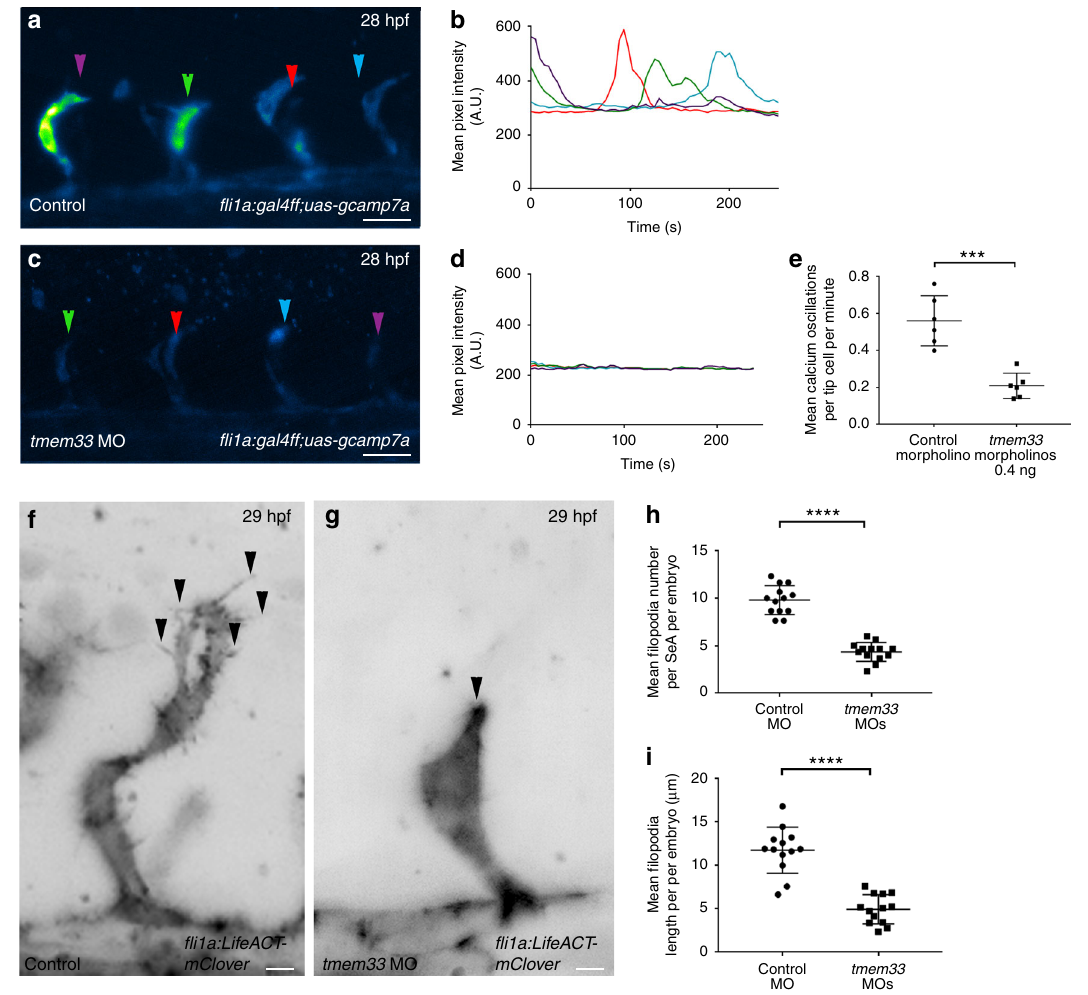
Fig. 2 tmem33 knockdown reduces Ca 2 + oscillations in tip cells and reduces EC fi lopodia. a – d tmem33 morphants injected with 0.4 ng morpholinos display reduced endothelial Ca 2 + oscillations. Intensity projections show Ca 2 + oscillations in both control and tmem33 morphants, highlighting intensity over duration of the time lapse. Change in fl uorescence over 300 s for four SeAs, trace colours correspond to equivalent arrowheads (scale bars 50 µ m). e tmem33 morphants display a signi fi cant reduction in Ca 2 + oscillations when compared with control morphants (unpaired t -test **** p = < 0.001; t = 5.633; DF = 10, 2 repeats, n = 3 embryos per group). f , g tmem33 morphants injected with 0.4 ng morpholinos display delayed migration of SeAs, which extend fewer fi lopodia, compared with controls (black arrowheads) (scale bars 5 µ m). h tmem33 morphants display signi fi cantly fewer fi lopodia per SeA compared with controls. Measurements taken from n = 4 SeAs per embryo. Unpaired t -test, **** p = < 0.0001; t = 7.805; DF = 24, 2 repeats, n = 6 or 7 embryos per group). i tmem33 morphants display reduced fi lopodia length compared with controls, measurements taken from n = 4 SeAs. Unpaired t